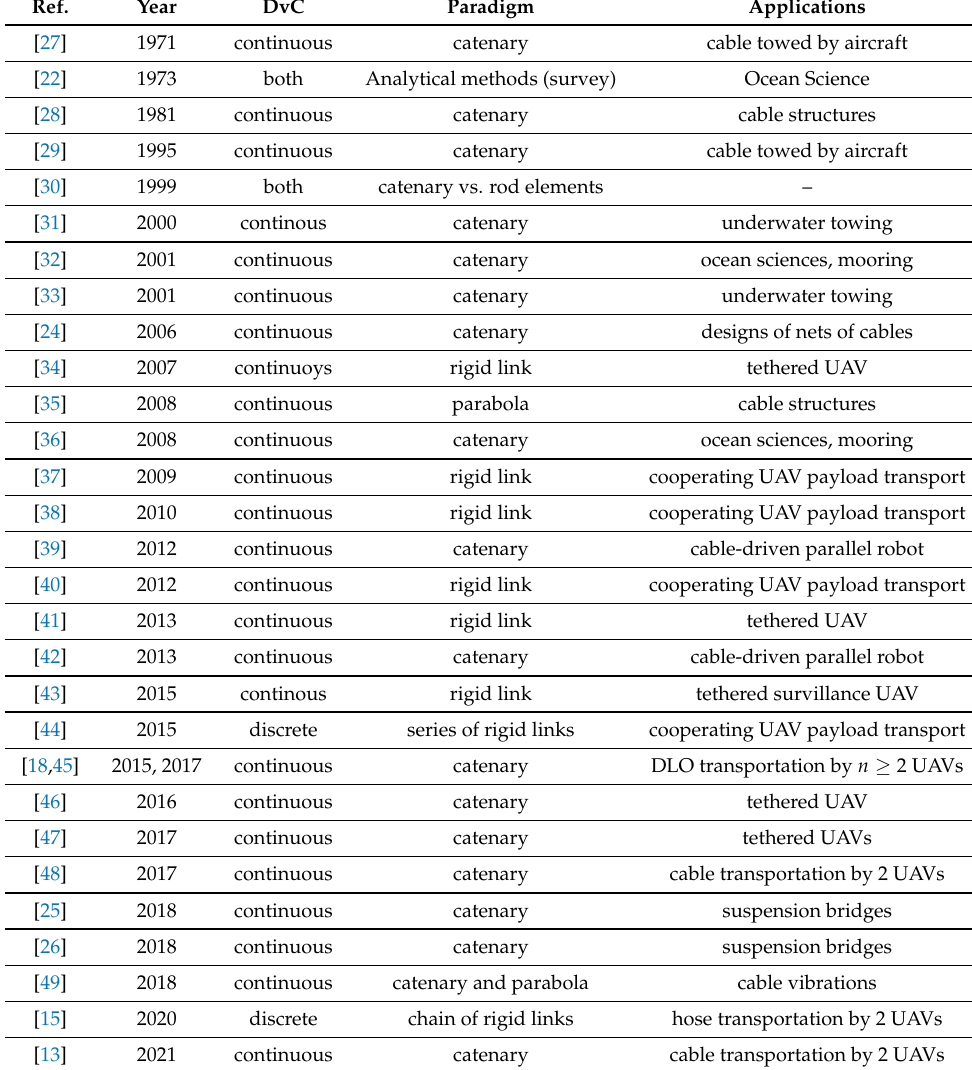
Table 1. Summary comparison of DLO related research. DvC = Discrete versus continuous model.